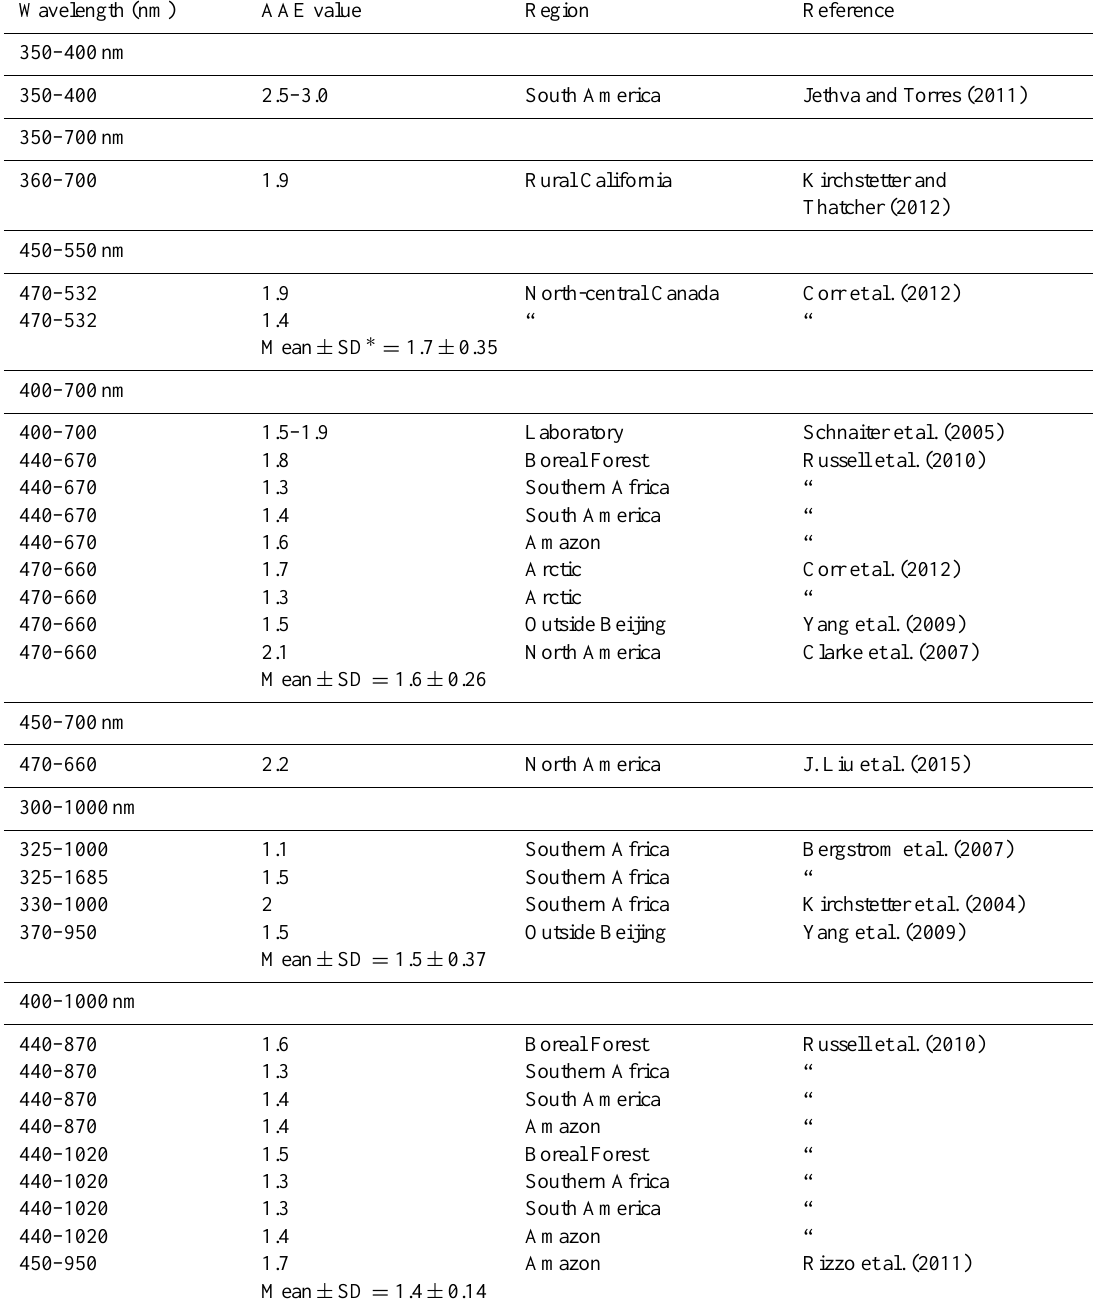
Table 1. Absorption Ångström exponent (AAE) values for biomass burning regions from the